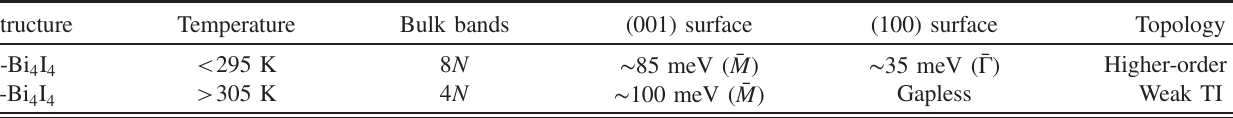
TABLE I. Summary of the key features on α -Bi 4 I 4 and β -Bi 4 I 4 revealed by our ARPES study.